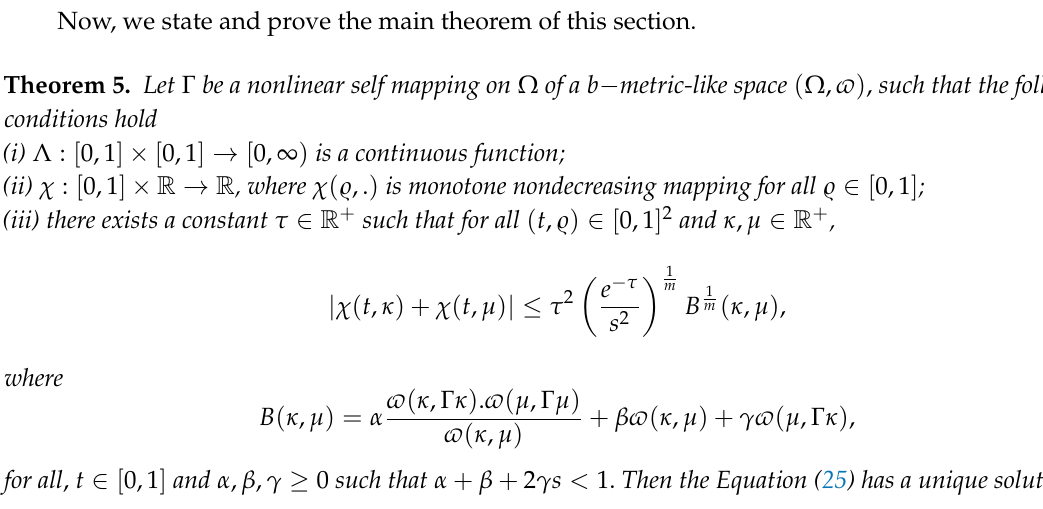
Figure 1. Electric